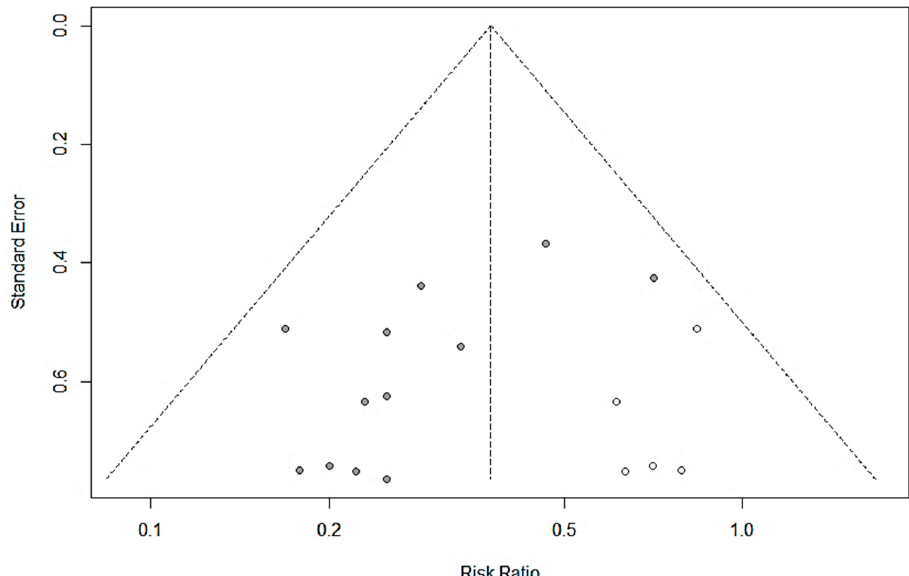
Figure 3. Funnel plot showing the relationship between the relative risk and its standard error for the 12 studies included (filled circles) and the potential 5 negative studies added to correct asymmetry using the Trim and Fill method (empty circles).